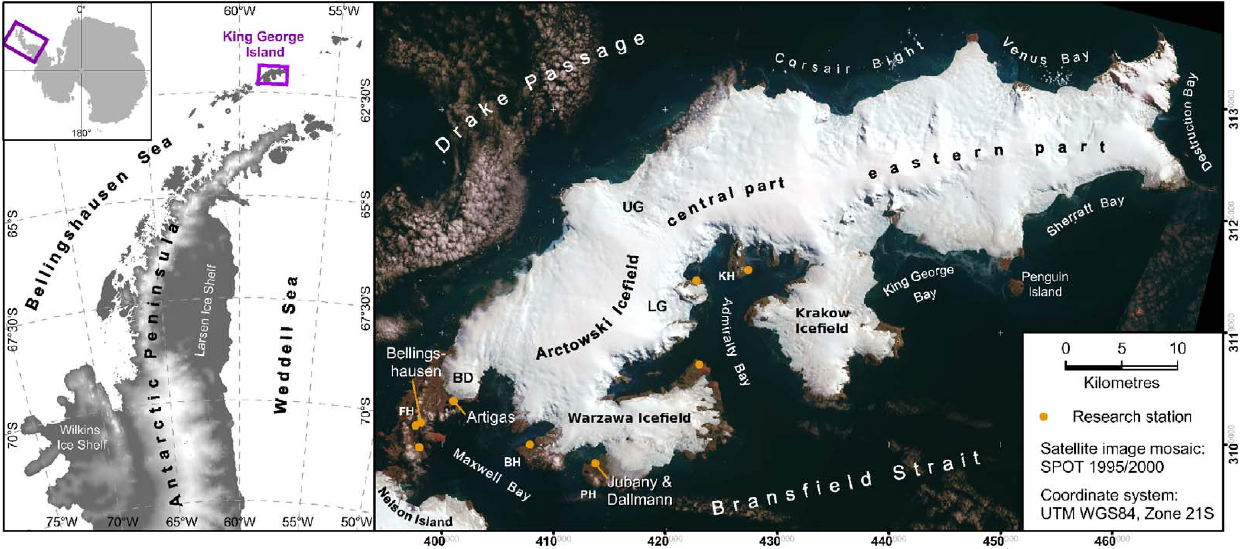
Figure 1. Overview map of King George Island and its location on the Antarctic Peninsula. FH denotes Fildes Peninsula, BH Barton Peninsula, PH Potter Peninsula, KH Keller Peninsula, BD Bellingshausen Dome, LG Lange Glacier, and UG Usher Glacier. Background Image is a © SPOT Image from 2000. Reprinted from the Annals of Glaciology with permission of the International Glaciological